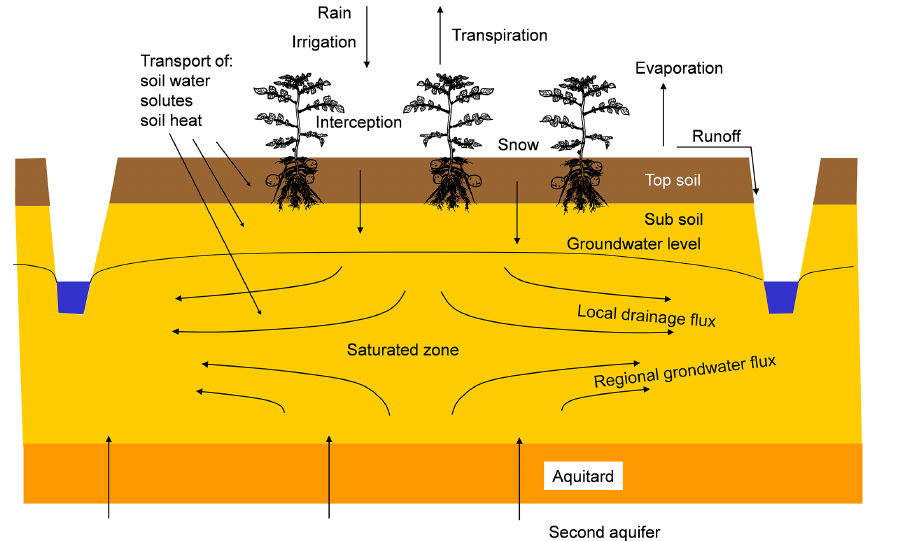
Figure 1. Transport processes and modelling domain of